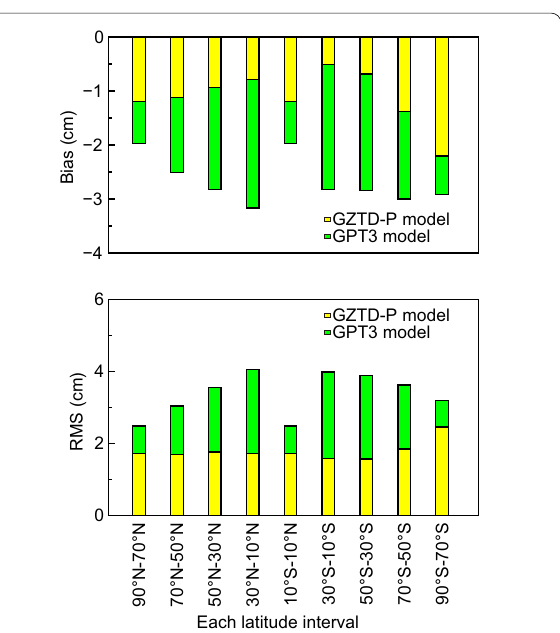
Fig. 8 The errors of the GZTD-P and GPT3 models in ZTD layered vertical interpolation in each latitude